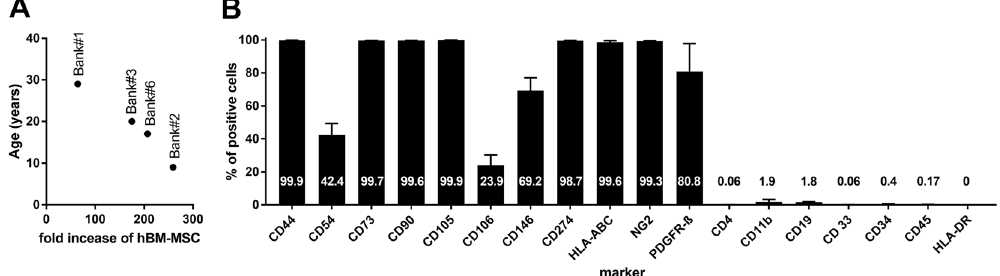
Figure 1. Age related cell kinetics and immunophenotypic characterization of cultured hBM-MSC. ( A ) Correlation between donor age and P0-P1 fold increase from 4 donors (Bank # 1, 3, 6 and 2) shown in descendent order of age. Significant inverse correlation between donor age and kinetic growth curve was found (p = 0.0147, r = − 0.985). ( B ) The expression of several immunophenotypic markers was determined by flow cytometry using specific monoclonal antibodies. Marker’s expression is indicated in bars as percentage of positive cells. Markers expected as positive are listed from CD44 to PDGFR- β whereas markers expected as negative are listed from CD4 to HLA-DR. Data are mean + SD from three independent